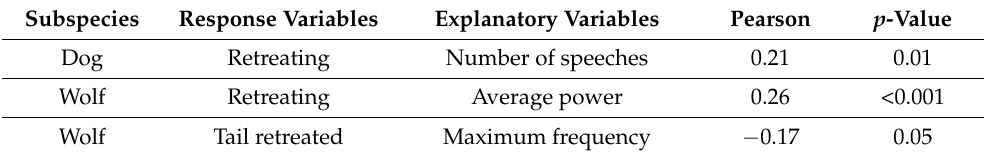
Table 10. Pearson correlations run for dogs ( Canis familiaris ) and wolves ( Canis lupus ), considering the effects of the acoustic characteristics of the trainers’ voices (average power, number of speeches, and maximum frequency) on the responses of the animals to training (retreating and tail